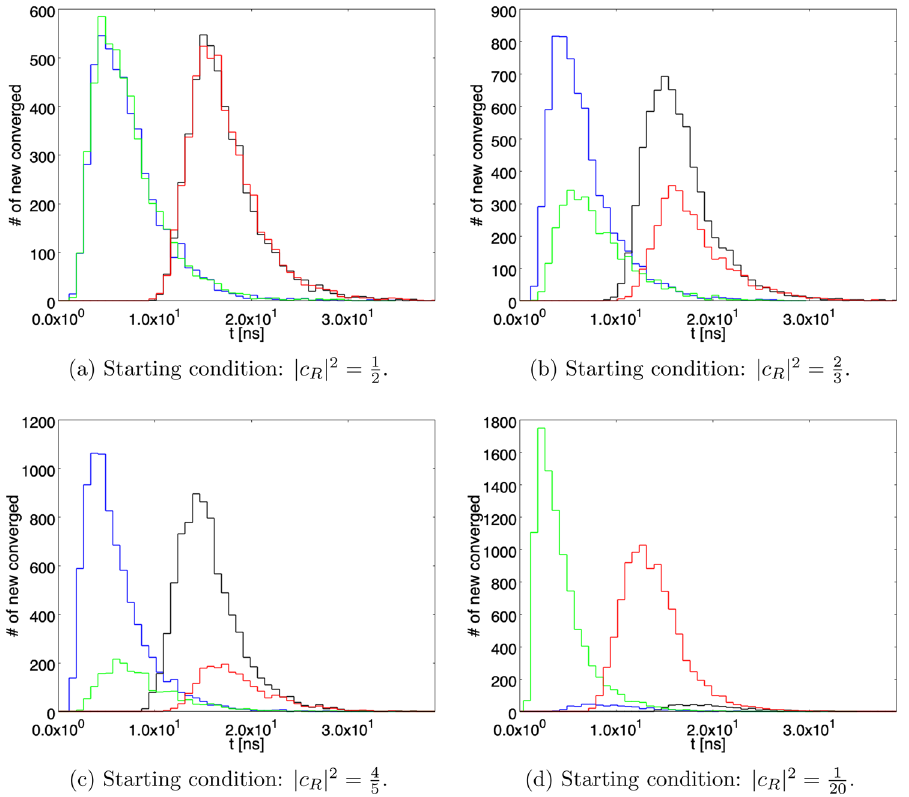
2 ≥ 1 − 𝜀 (blue and black histograms for von c R 2 ≤ 𝜀 (green and red histograms c | | R | |